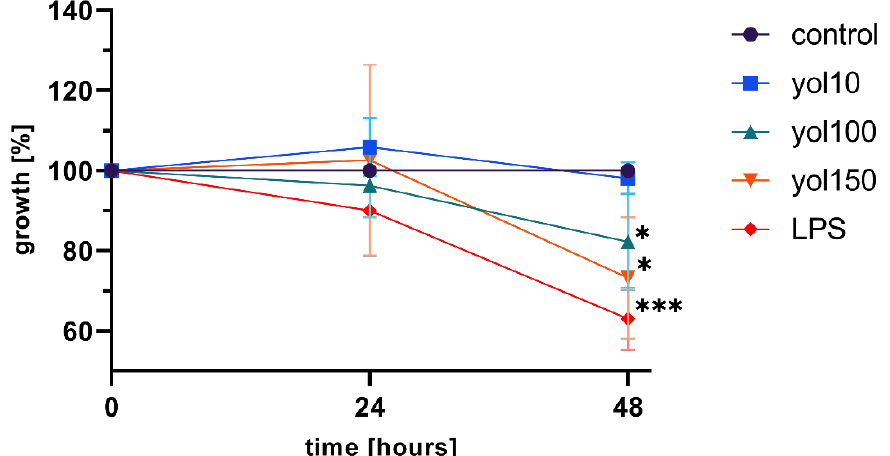
Figure 2. Effect of yolkin on viability and proliferation of bone marrow-derived macrophages (BMDM). The cells (1 × 10 5 /mL) were seeded in 96-well plates in DMEM + 10% FBS and incubated overnight at 37 ◦ C. Next, the cells were exposed to yolkin (10, 100 and 150 µ g/mL) for 24 and 48 h. The cell proliferation activity of yolkin was assessed with an MTT assay. Non-stimulated cells were used as a negative control. The results represent three to five independent experiments and data are presented as median ± min–max. A one-sample t -test was used to examine the mean differences between samples and control (100). * p ≤ 0.05, *** p ≤ 0 .0001.